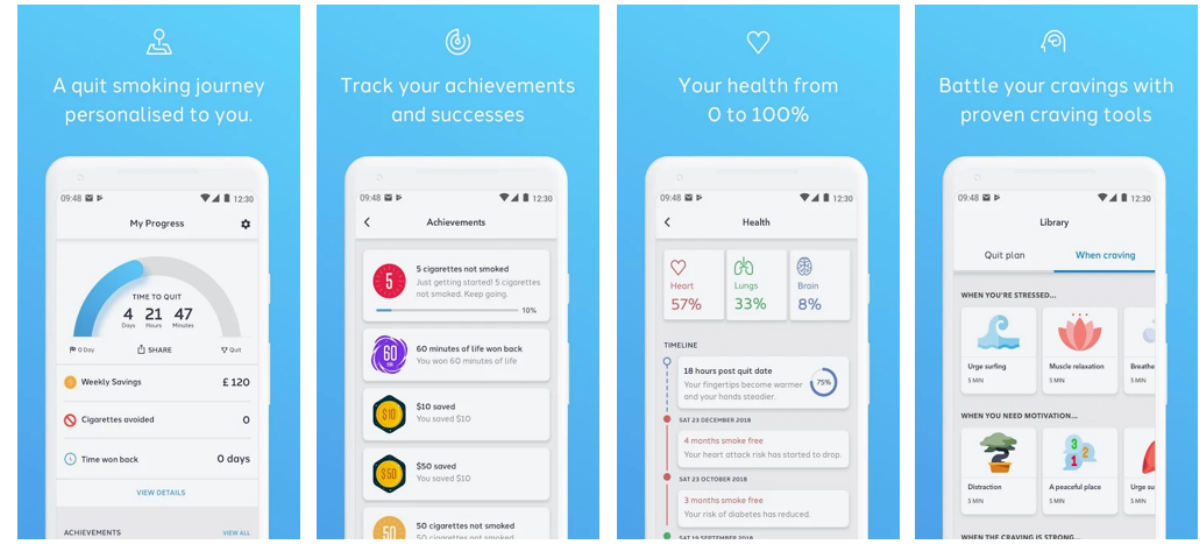
Figure 1. Screenshots of Quit